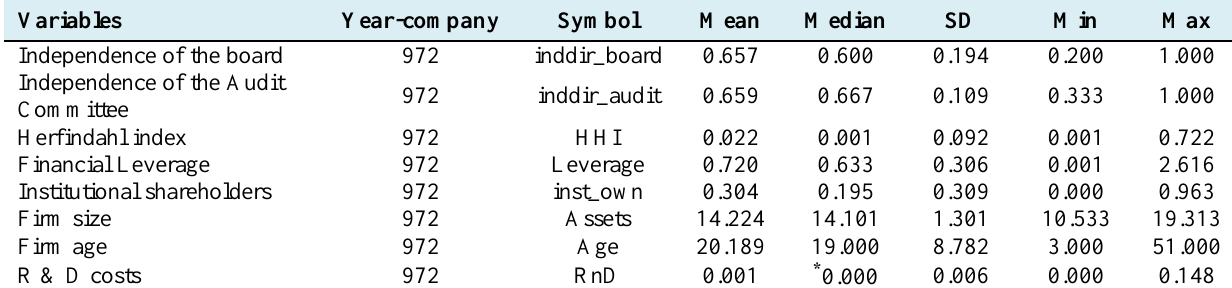
Table 1. Descriptive statistics of quantitative variables related to the models of research hypotheses testing